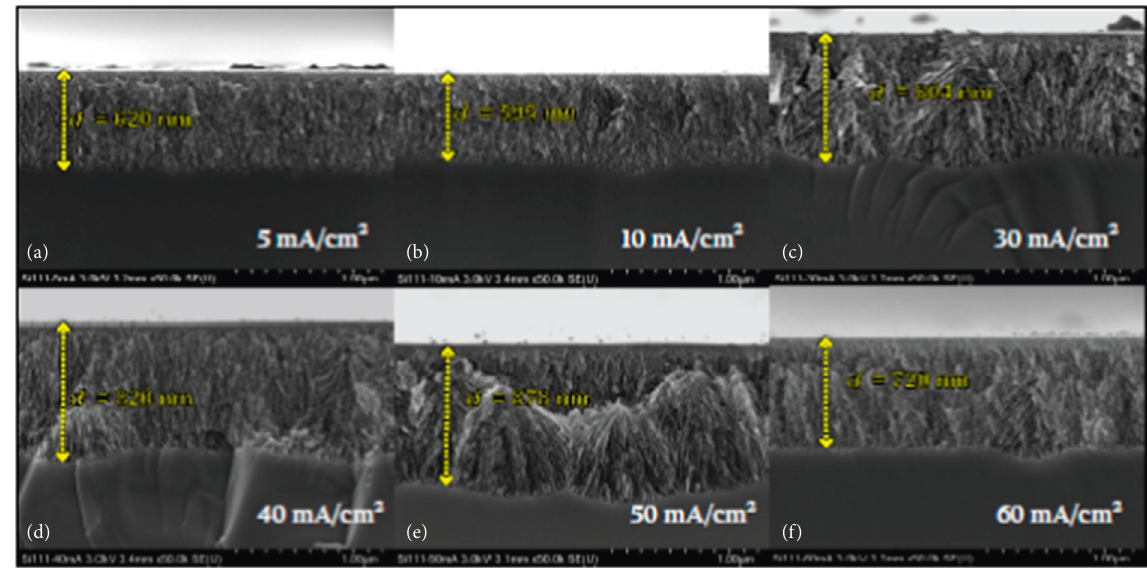
Figure 5: Cross section SEM images of PSi films at different anodizing current densities (at mA · cm − 2 ): (a) –5; (b) –10; (c) –30; (d) –40; (e) –50; (f) –60. The micrographs show the interface between the PSi film and bulk [71] under the terms of the creative commons CC BY license.